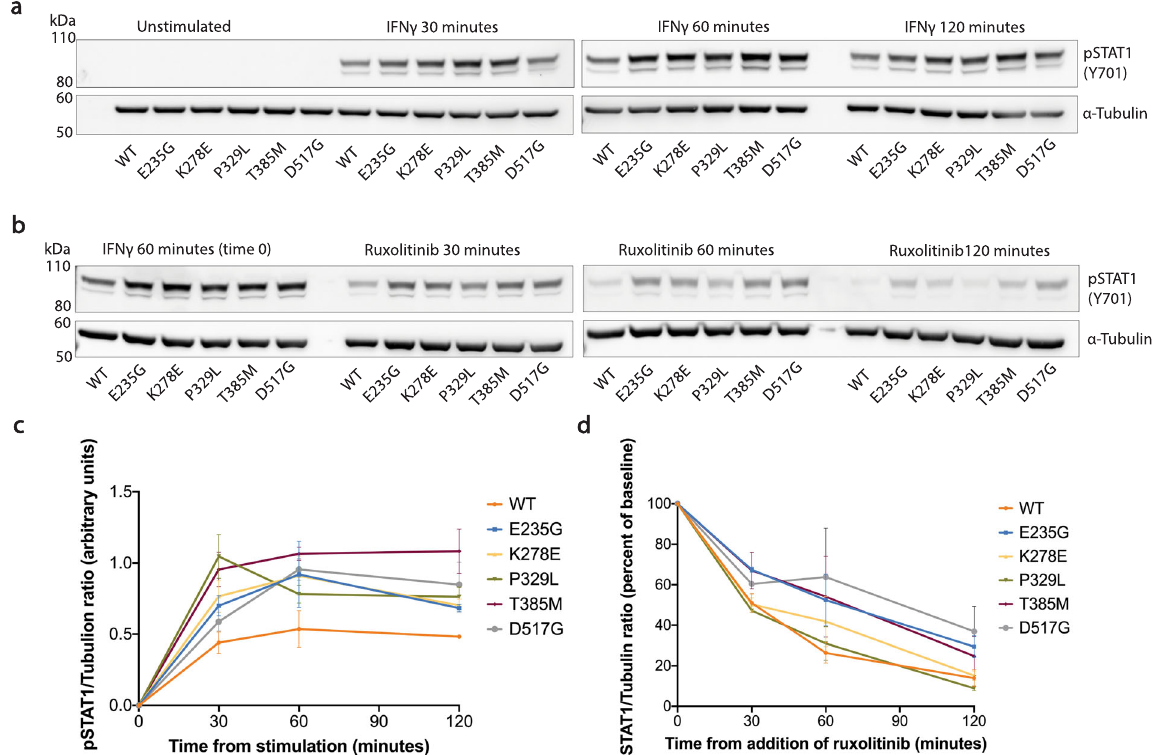
Fig. 5 Time-course analysis of STAT1 phosphorylation and de-phosphorylation among wild type and gain-of-function mutants following IFN γ stimulation. a Levels of pSTAT1 were measured in whole-cell protein lysates at baseline, and following 30, 60, or 120 min of stimulation with IFN γ (10 ng/mL). Results were normalized to α -Tubulin loading control. b Levels of pSTAT1 were measured after 60 min of stimulation with IFN γ (10 ng/mL), and at 30, 60, or 120 min following addition of the Janus-kinase inhibitor, Ruxolitinib (10 μ M). Experiments